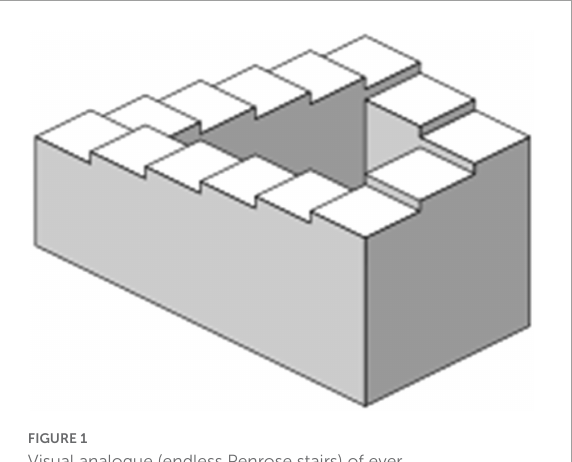
FIGURE1 Visual analogue (endless Penrose stairs) of ever ascending/descending sound sequence created by Shepard (reproduced from